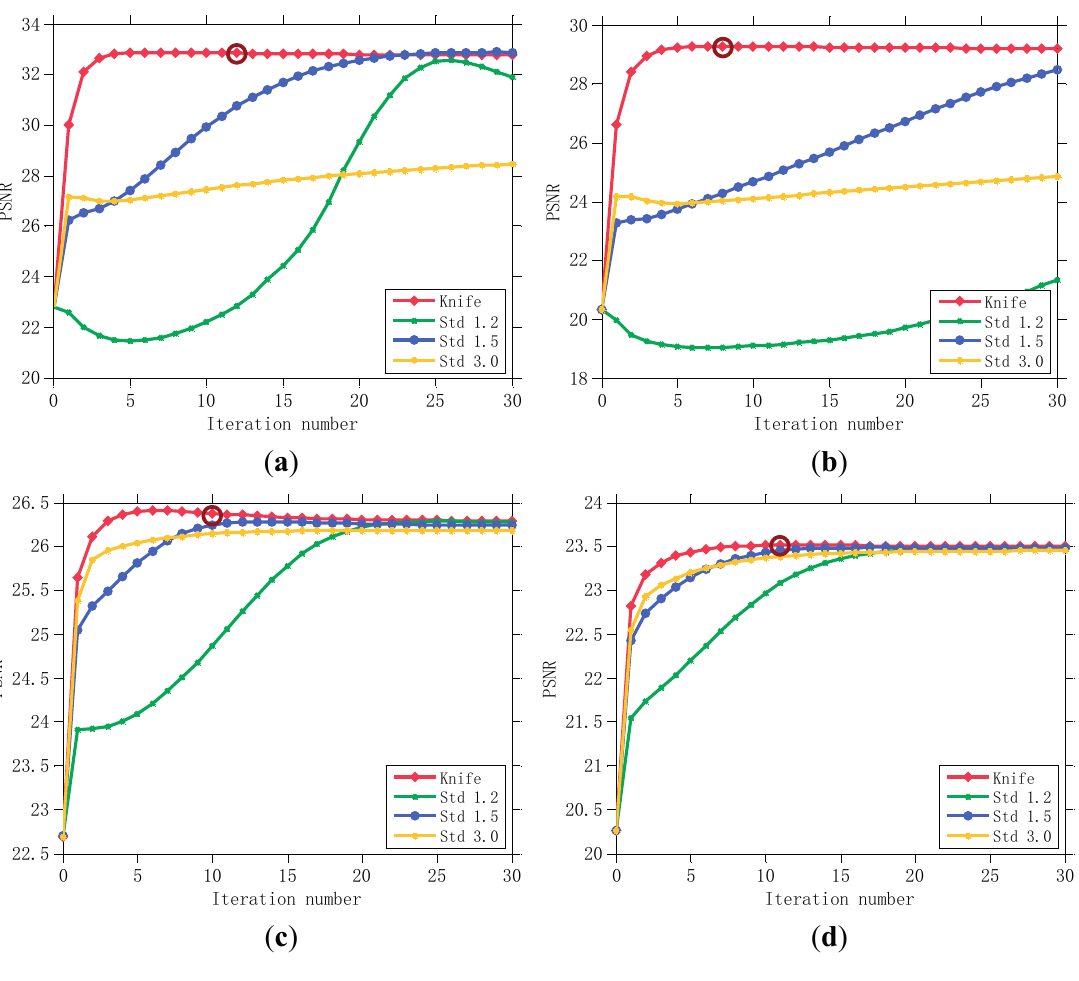
Figure 13. Evolution of PSNR with iterations using different initializations. The AM framework is initialized with the proposed PSF estimation method and with manually selected PSF initializations (a 5 × 5 truncated Gaussian PSF with a standard deviation of 1.2, 1.5, and 3.0), represented by “Knife,” “Std 1.2,” “Std 1.5,” and “Std 3.0,” respectively. Stopping positions utilizing the proposed automatic stopping strategy are marked by circles. ( a – d ) correspond to the iterations of Figures 5–8a,